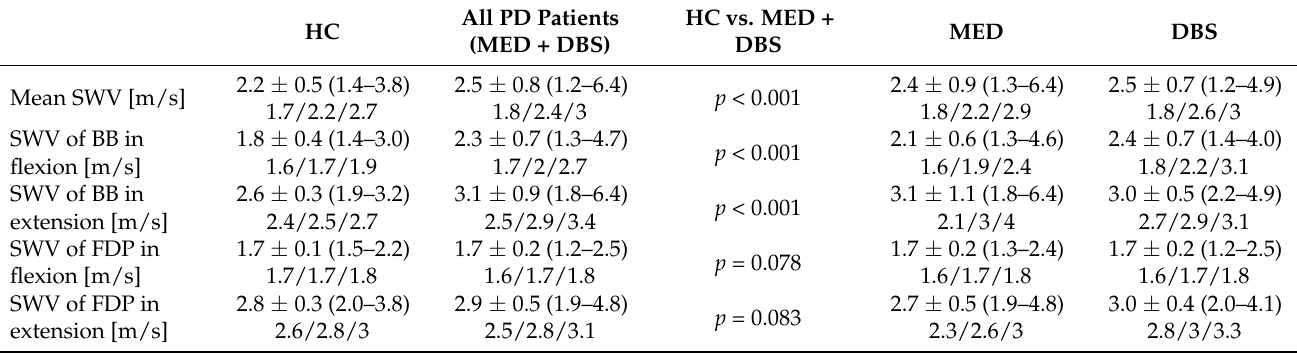
Table 2. Mean shear wave velocity (SWV) indicated for the groups of participants in different muscles and positions over an 80 min time interval. Mean ± standard deviation, quartiles 25/50/50 (minimum—maximum). Overall average values of SWV in meters per second [m/s] for both muscles biceps brachii (BB) and flexor digitorum profundus (FDP), in two positions: Flexion and extension. All PD Patients HC (MED +